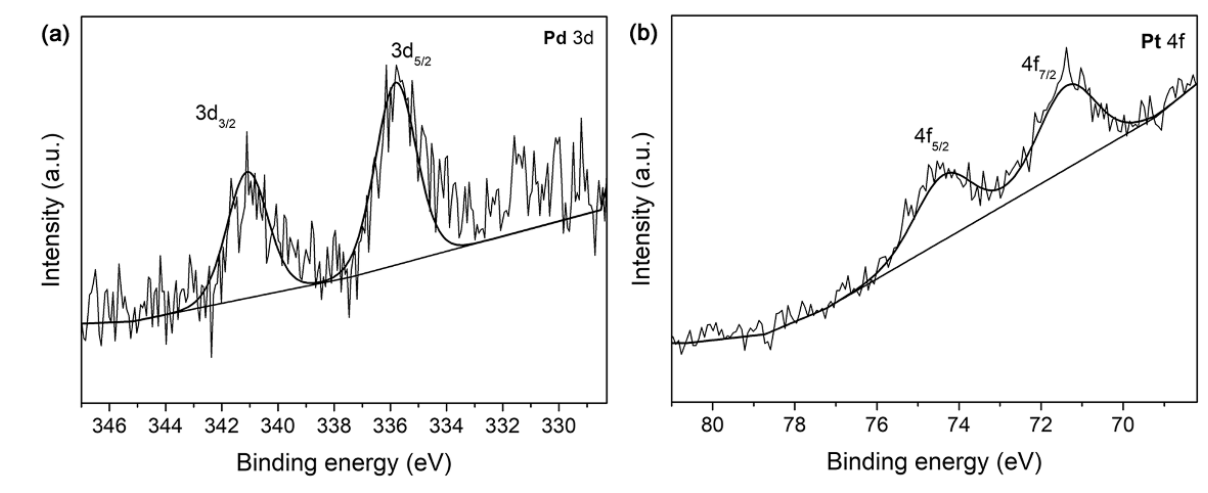
Figure 7. XPS spectra of Pt-PdS/CdS(HZ) in the ( a ) Pd 3d and ( b ) Pt 4f regions.